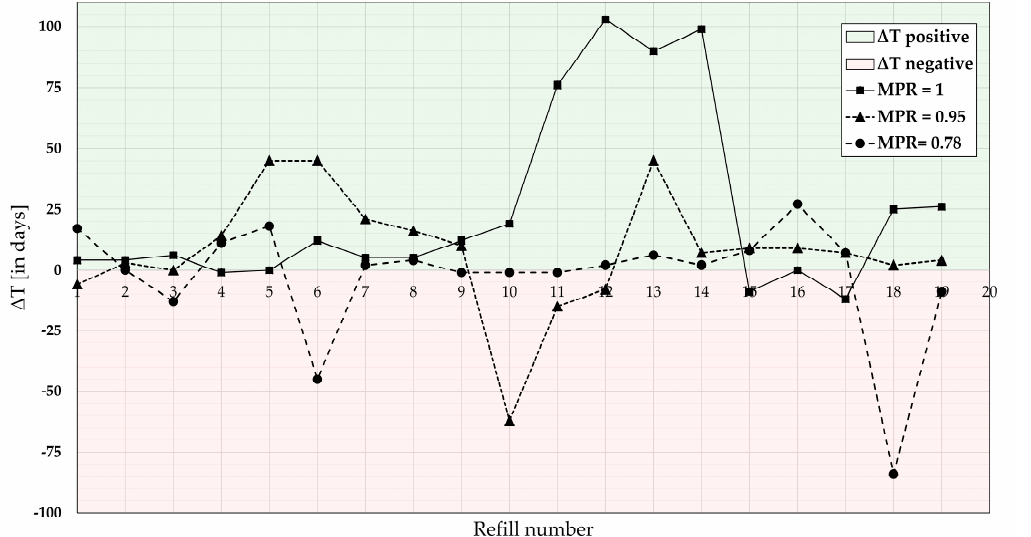
Figure 3. Unique refill patterns with ∆ T from three illustrative patients with MPR of 1 (square), of 0.95 (triangle), and of 0.78 (dots) over the period of 19 refills. The green area above the x-axis indicates positive ∆ T that is, refilling too early and oversupply; the red area below the x-axis indicates negative ∆ T that is, refilling too late and gaps in DOAC supply.